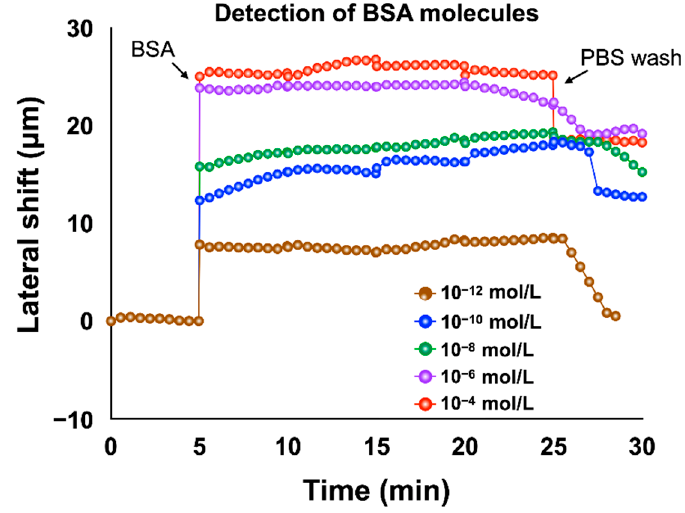
Figure 8. Real-time detection of different concentration of BSA solutions based on lateral position shift measurement.